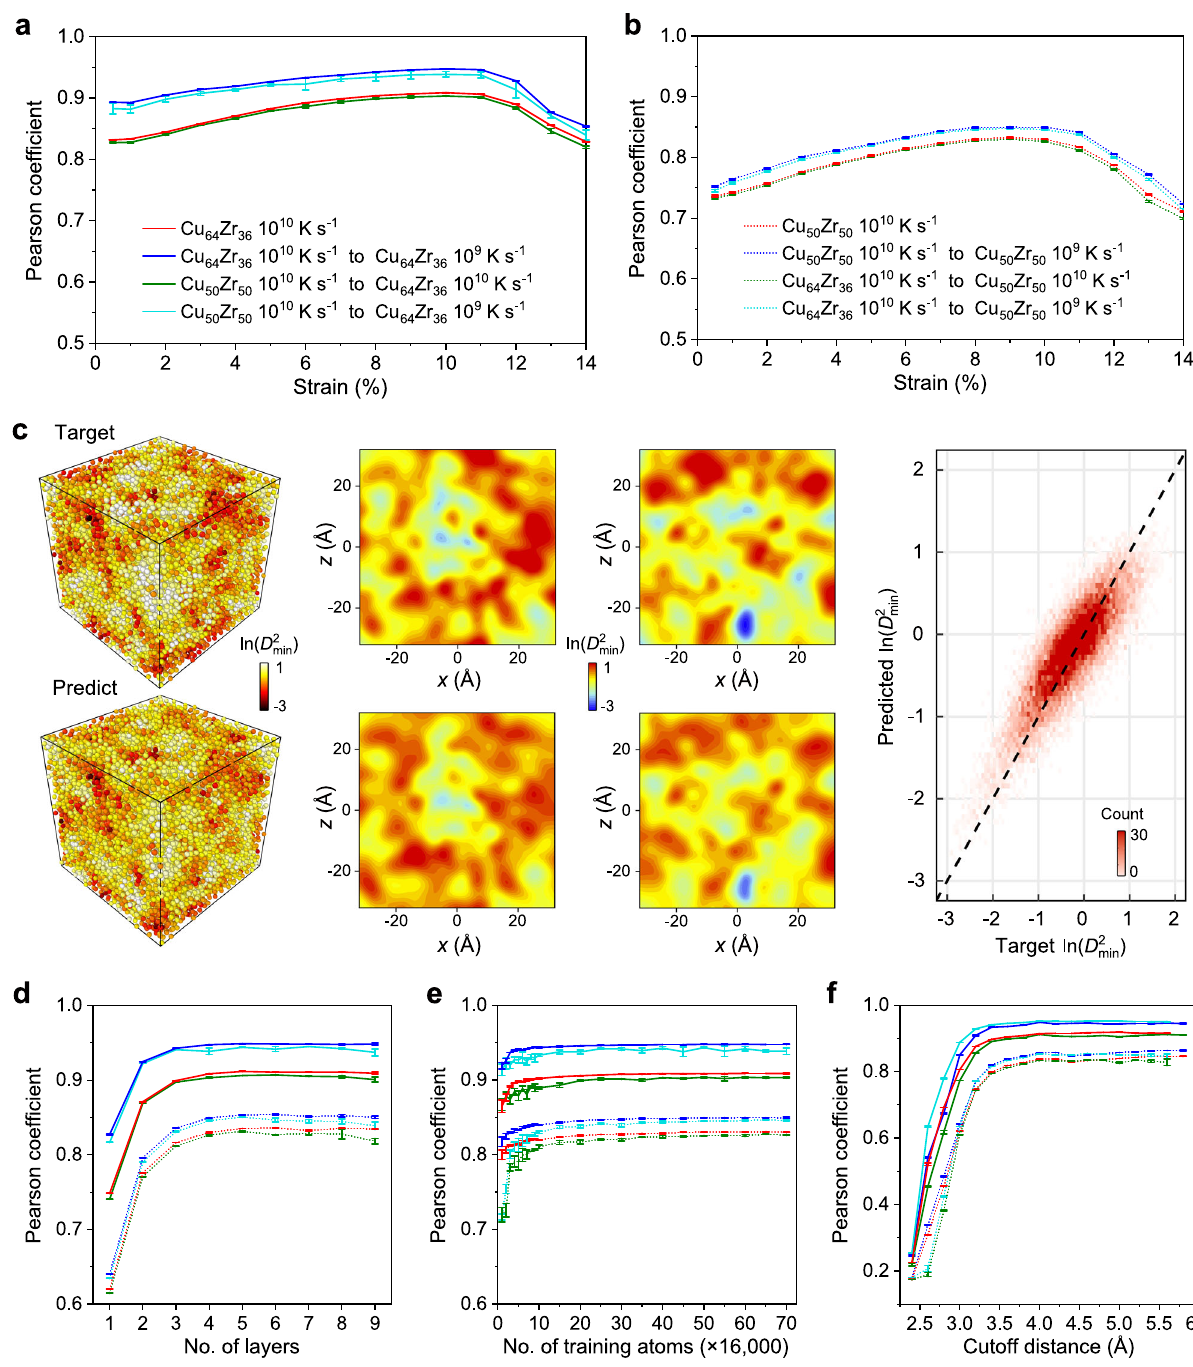
) prediction for each strain of ( a ) Cu 64 Zr 36 and ( b ) Cu 50 Zr 50 , Fig. 2 Predicting the plastic propensity using GNN. a – b Pearson coef fi cient of ln( D 2 min respectively. Each point and the error bar show the average and standard deviation of an ensemble of ten independently trained GNN models. The GNN generalization results between quenching rates or/and compositions are also presented. c Target (simulated, upper row) versus GNN predicted (lower row) ln( D 2 ) of a Cu 50 Zr 50 – 10 9 K s − 1 con fi guration at strain 10%. Linear interpolation of ln( D 2 ) in typical slices of 3 Å thickness are compared in the min min middle panel (more slices of different strains, compositions, and quenching rates in Supplementary Figs. 1 – 4). The parity plot of the target and predicted ln( D 2 ) is in the right panel. d – f Pearson coef fi cient with varying ( d ) number of GNN layers, ( e ) number of atoms for training (derived from number of min training con fi gurations, each containing 16,000 atoms), and ( f ) cutoff distance in designating the nearest (hop-1) neighbors when building graphs around this meta-stable state. As another comparison, rejuvenation in experiments could even introduce ~300 meV/atom into the glass 11 . the overall distribution of Zr (Fig. 3c). This is further supported by the weak correlation between local energy and ln( D 2 ), with low min Pearson correlation coef fi cients of 0.269 and 0.148 for Cu and Zr,